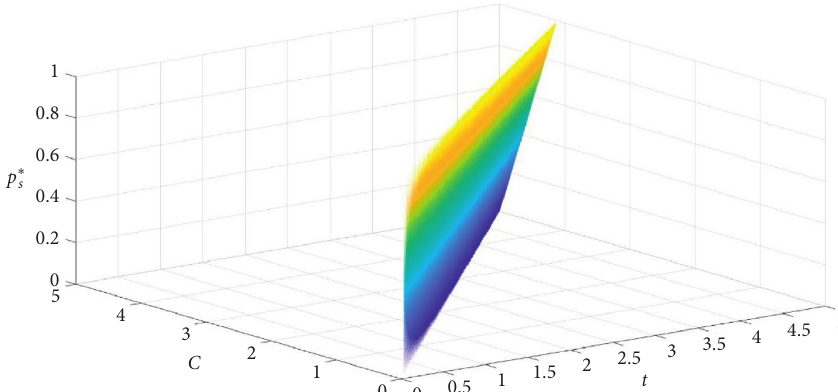
Figure 3: Simulation diagram of the influence of private enterprises’ maximum rent-seeking profit and rent-seeking cost on optimal supervision probability p ∗ s .